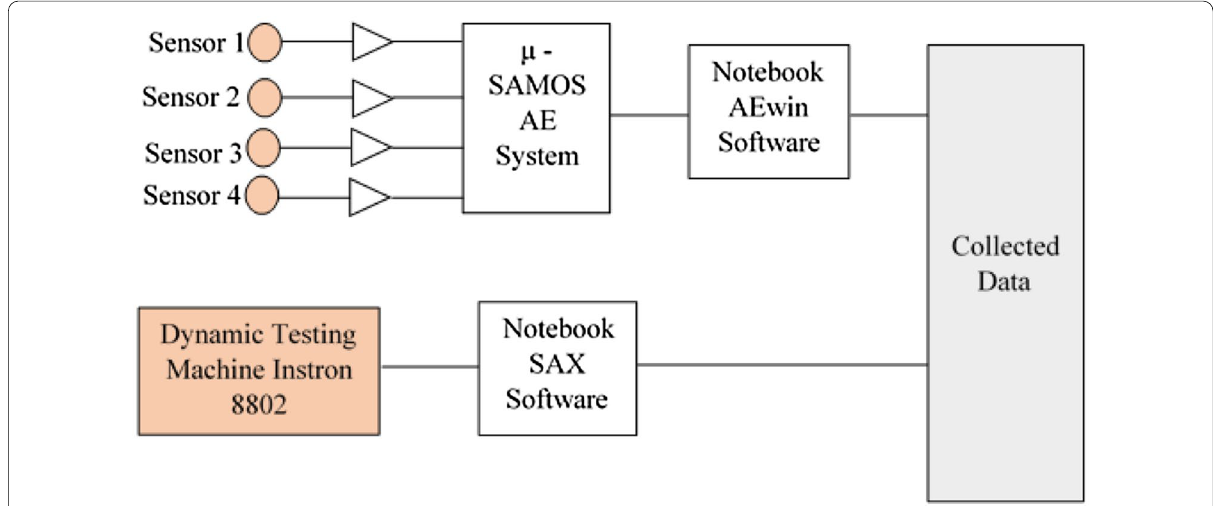
Fig. 3 Complete schematic diagram of the connection setup.